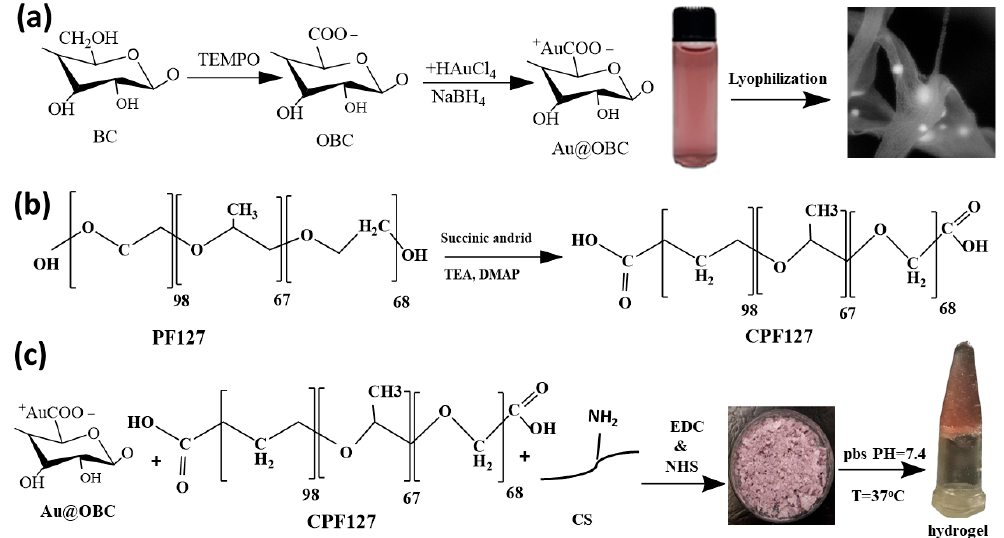
Figure 1. Schematic representation of the procedures employed for ( a ) in situ synthesis of AuNPs on bacterial cellulose nanofibers, ( b ) carboxylation of Pluronic F-127, and ( c ) production of electroconductive and thermosensitive nanocomposite hydrogels for cardiac tissue engineering.